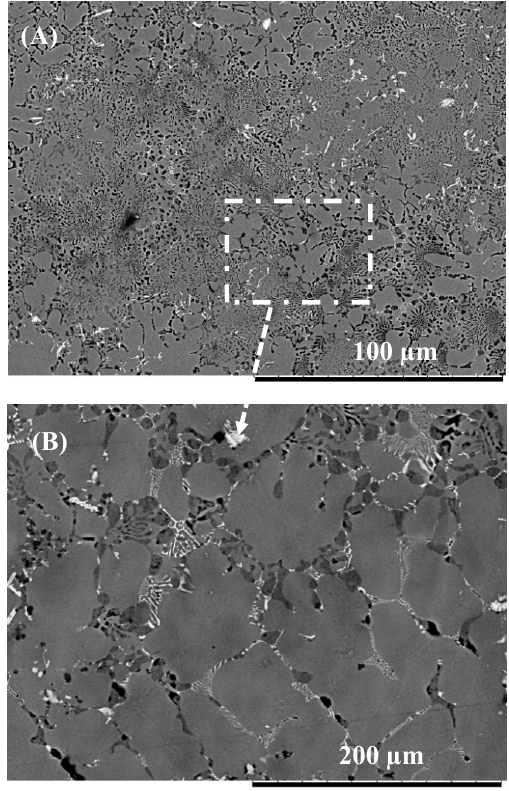
Figure 4. Eutectic microstructure formed at the joint interface during diffusion brazing. ( A ) Eutectic microstructure formed using pure-Cu. ( B ) Energy dispersive spectroscopy (EDS) spectrum of region- 1. ( C ) Eutectic microstructure formed using Cu/Al 2 O 3 interlayer. ( D ) EDS spectrum of region-2.